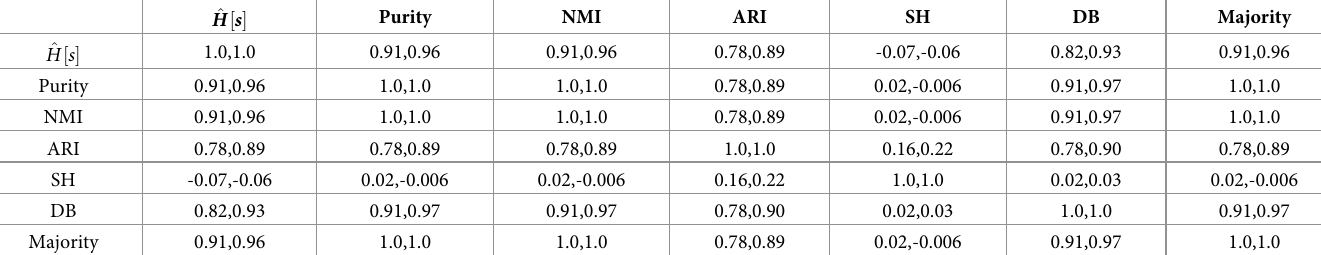
Table 3. Kendall’s τ and Spearman’s correlation result for stock considering SEC codes at 3